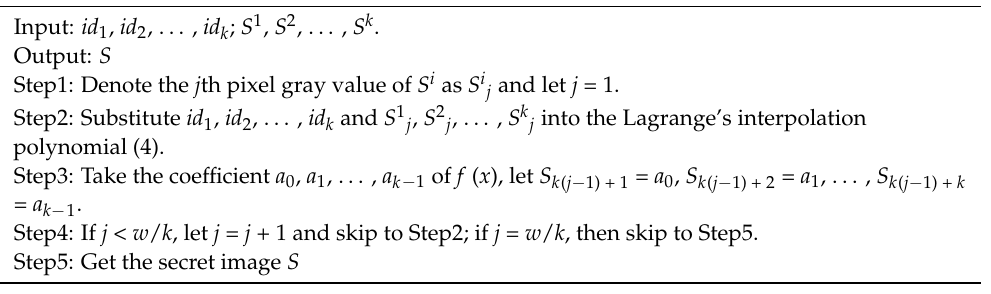
Algorithm 2 Thien and Lin’s secret image recovery